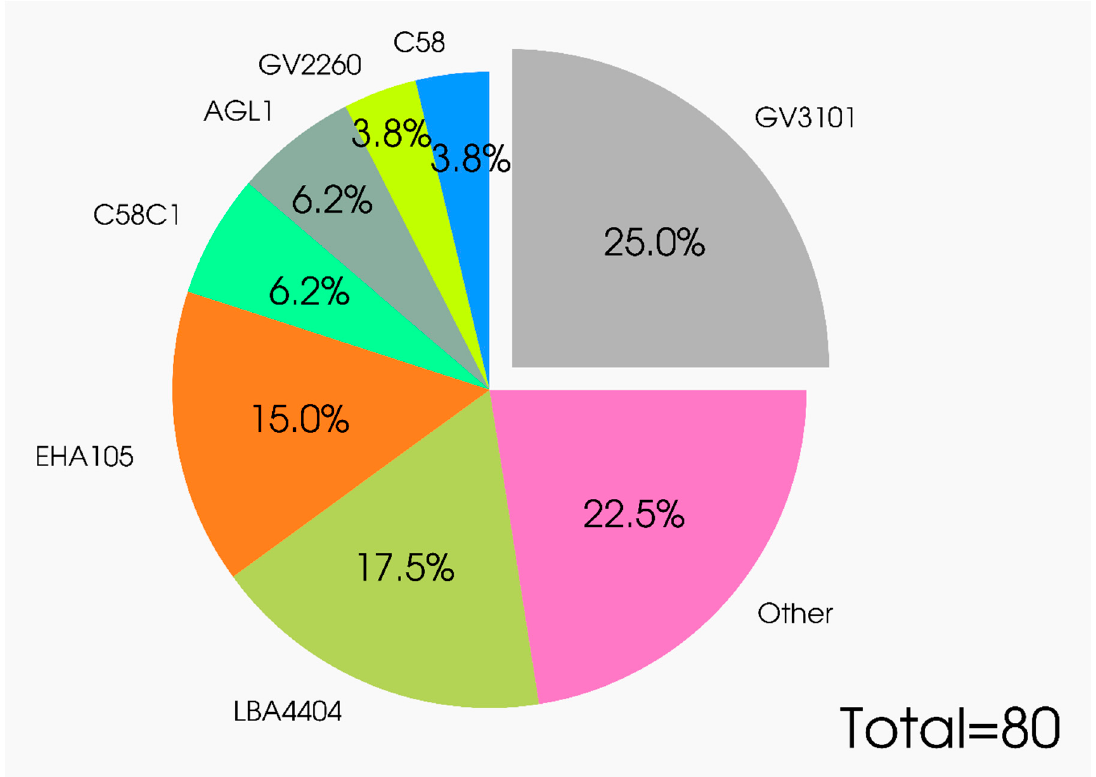
Figure 6. Usage of A.tumefaciens strains in transient gene expression in plants. The percentage of agrobacterial strains usage in transient gene expression in plants is calculated based on scientific articles (Supplemental Table S1).